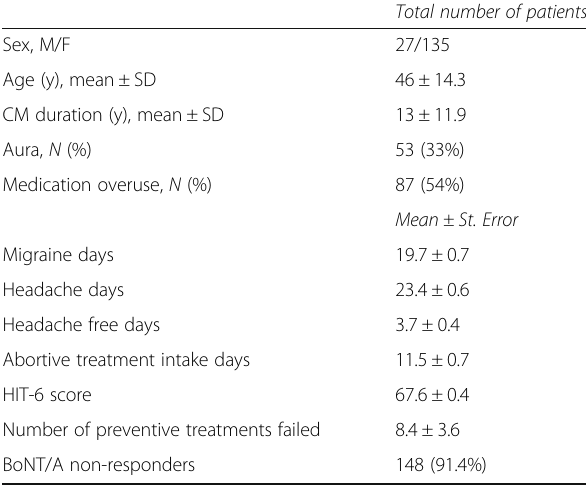
BoNTA: onabotulinum toxinA, CM , chronic migraine; F , female; HIT-6 , headache impact test-6; M , male; N , number; Y ,